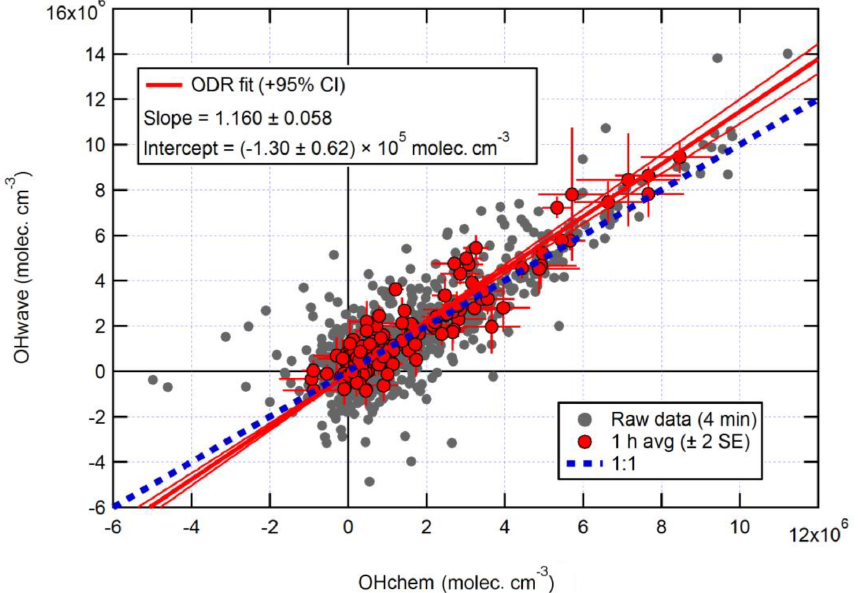
Figure 10. Overall intercomparison of OH wave and OH chem observations from the ICOZA campaign. Grey markers represent raw data (4min), with 1h averages ( ± 2 standard error, SE) in red. The thick red line is the orthogonal distance regression (ODR) fit to the hourly data, with its 95% confidence interval (CI) bands given by the thin red lines; fit errors are given at the 2 σ level. For comparison, 1 : 1 agreement is denoted by the dashed blue line. OH wave data were corrected for the known interference from O 3 + H 2